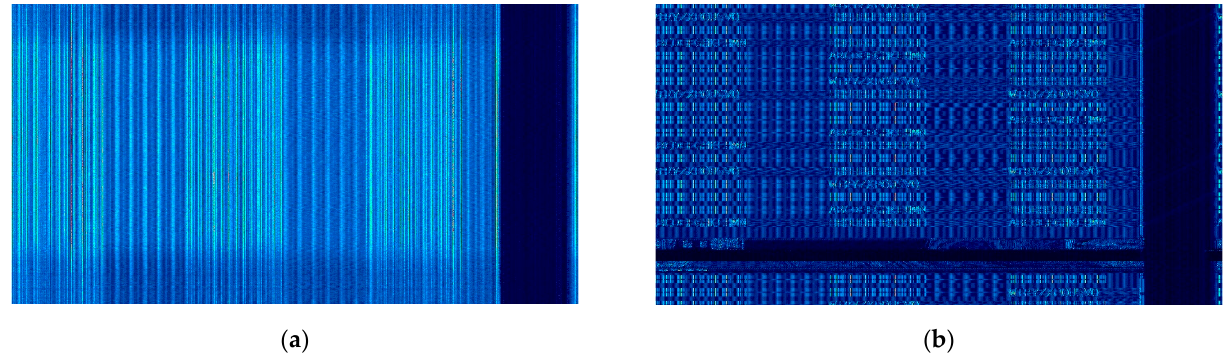
Figure 14. Images reconstructed from the revealing emission signal measured at the frequency f o = 200 MHz for the number of lines of this image determined in accordance with the criterion of the maximum value of the measures presented in Figure 13: ( a ) the number of image lines determined in accordance with method V ( B = 1114, the number of lines smaller than required), ( b ) number of image lines determined in accordance with methods I, II, III, IV, VI, and VII ( B Corr = 1125, correct number of lines). Primary Image in the Form of the Text Presented in Figure 7c ( B Entr = 809, d = 259,256,078) Figure 15 (Table 3) shows the changes in the values of the adopted measures (methods) calculated as a function of the number lines of the image reconstructed from the recorded revealing emission signal. The criterion for which the correct number of image lines is indicated is the maximum value of the calculated measure (method, Figure 16).